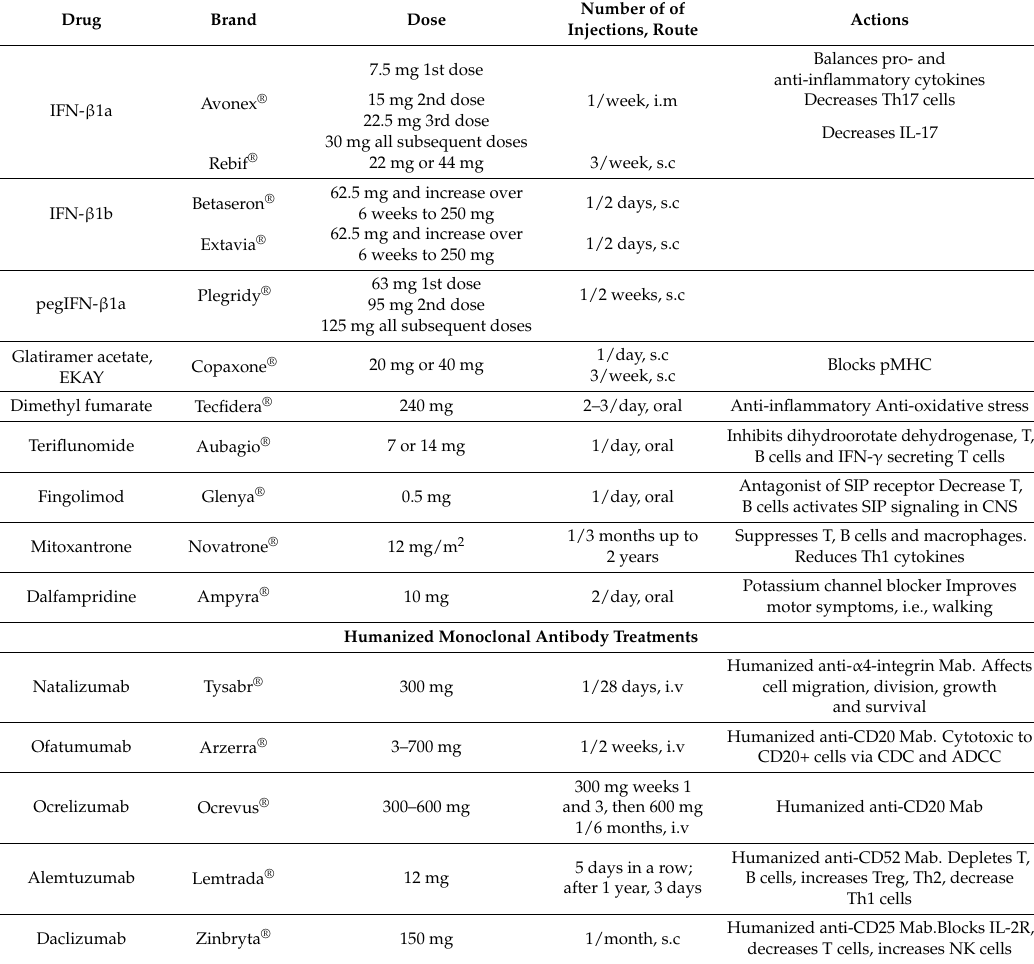
Table 1. Disease-modifying drugs available to patients with